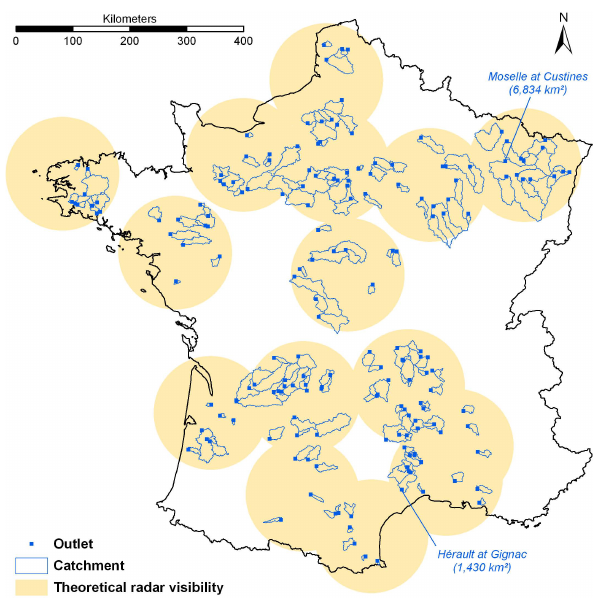
Fig. 2. Locations of the 181 French catchments used in this